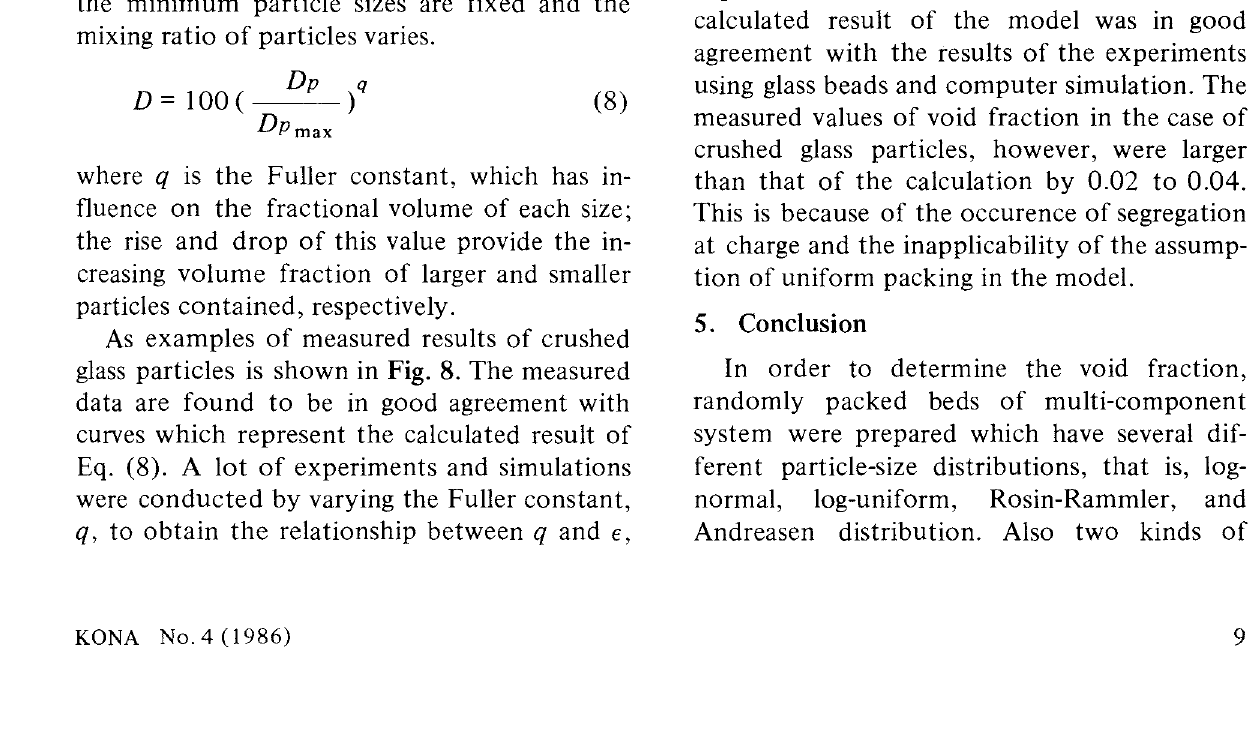
Fig. 7 Comparison between calculated, simulated and experimental void fractions for spheres and irregularly shaped particles with Rosin Rammler size distribution